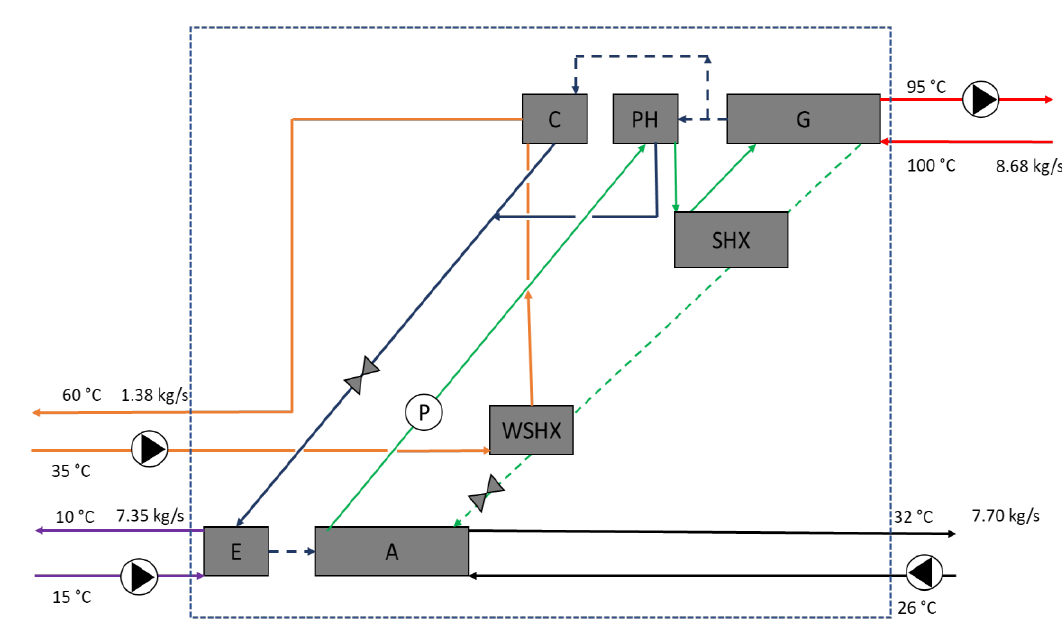
Figure 14. Working temperatures and flow rates for the simultaneous heating and cooling for a sports center with an indoor swimming pool. Table 5. Absorption heat pump performance for an indoor swimming pool.